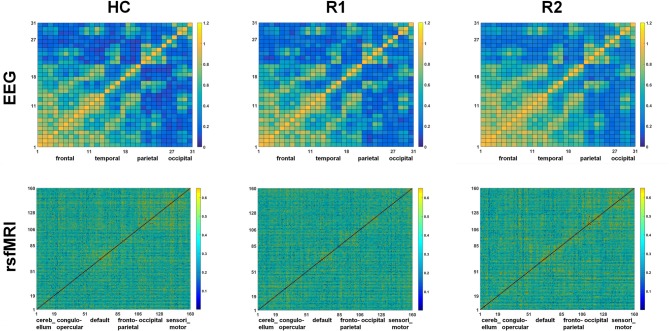
Comparison of the correlation metrics of 31 electrodes in the beta2 frequency range in EEG and correlation metrics of 160 regions in rsfMRI in HC, R1 and R2.